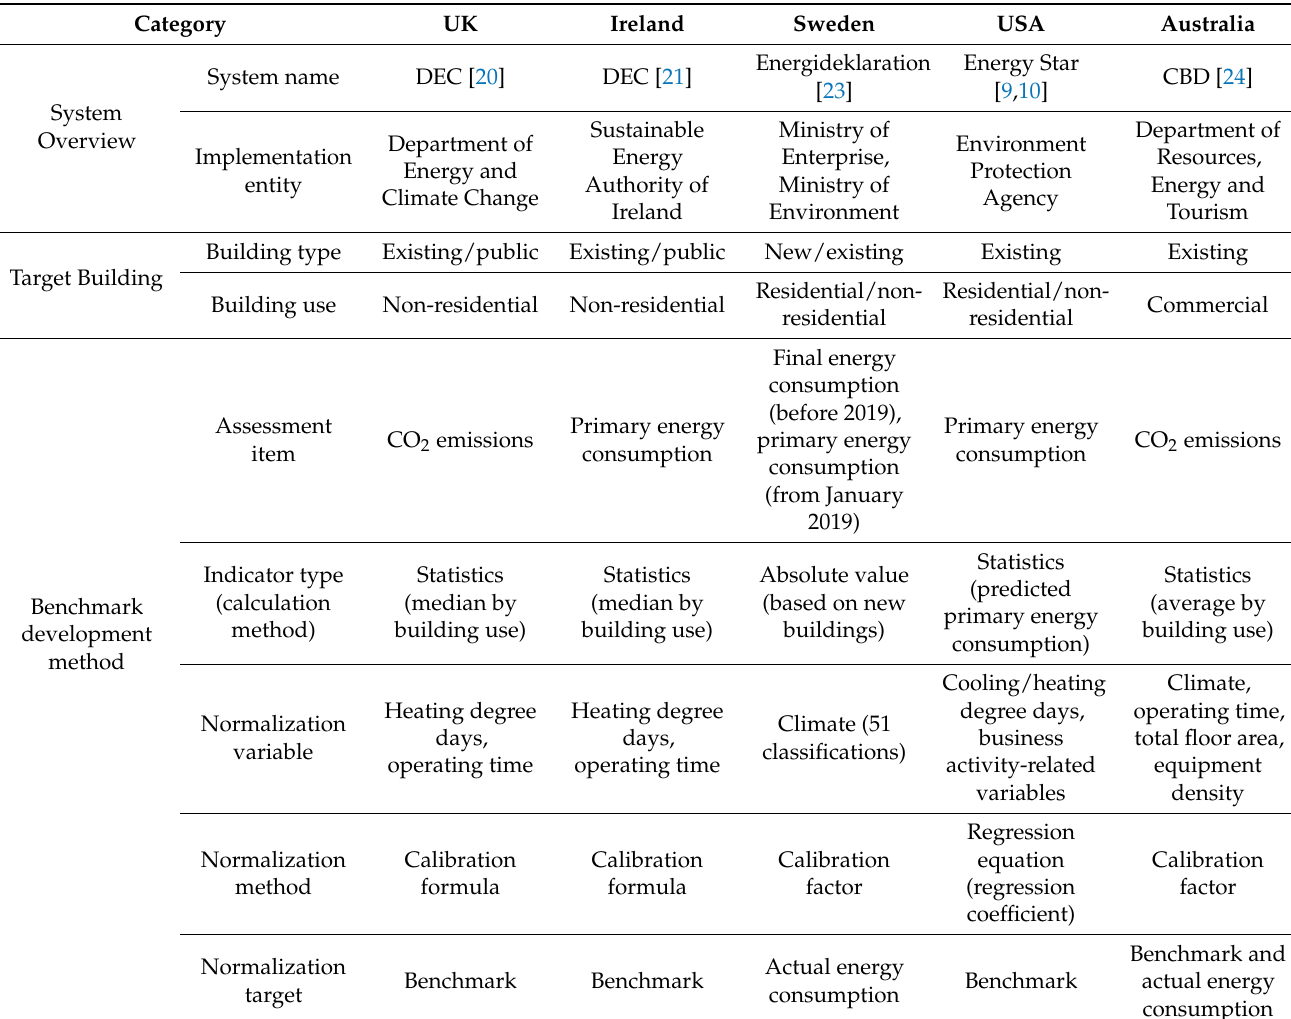
Table 4. Benchmark development method by